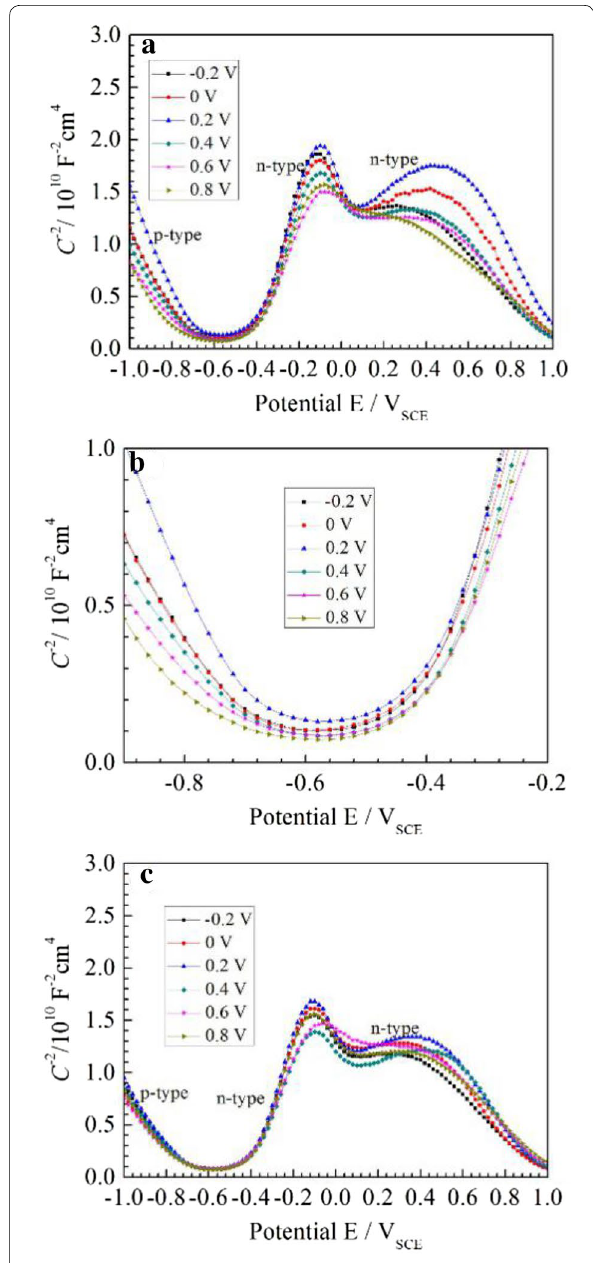
Figure 6 The Mott-Schottky plots for the 304 stainless steels in borate buffer solution measured at different oxide formation potential: ( a ) full figure of As-received specimens; ( b ) magnification between 0.9 ~ 0.2 V SCE ; ( c ) sensitized − −